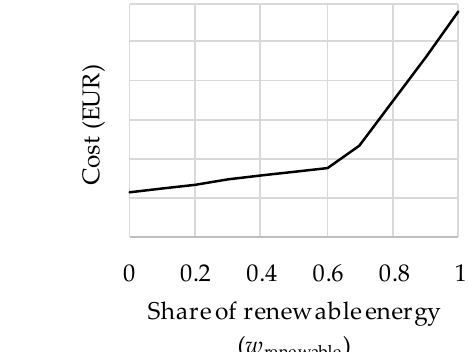
Figure 5. Composition of energy mix (left) and cost (right) while increasing the fraction of renewable energy in the electricity mix.